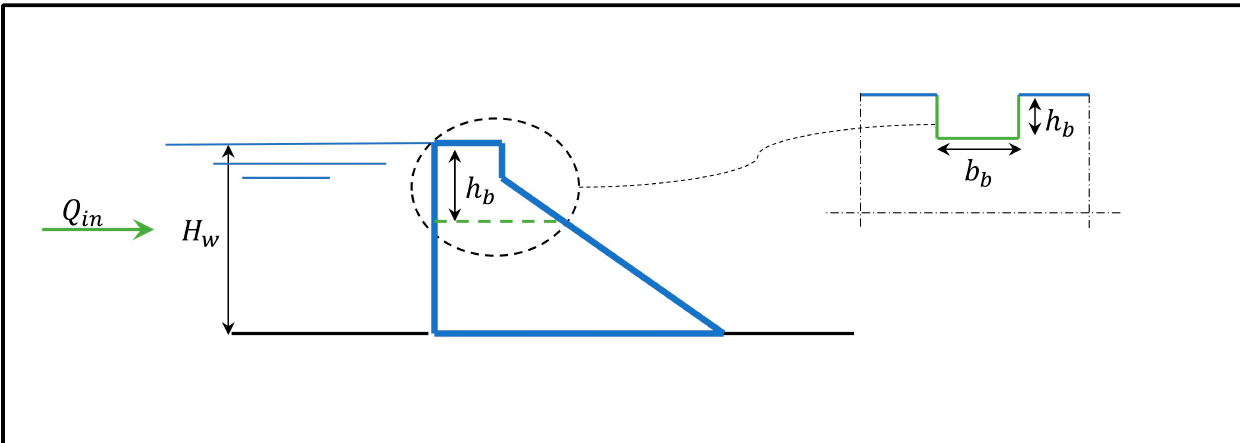
Figure 4. Dam breach parameters.